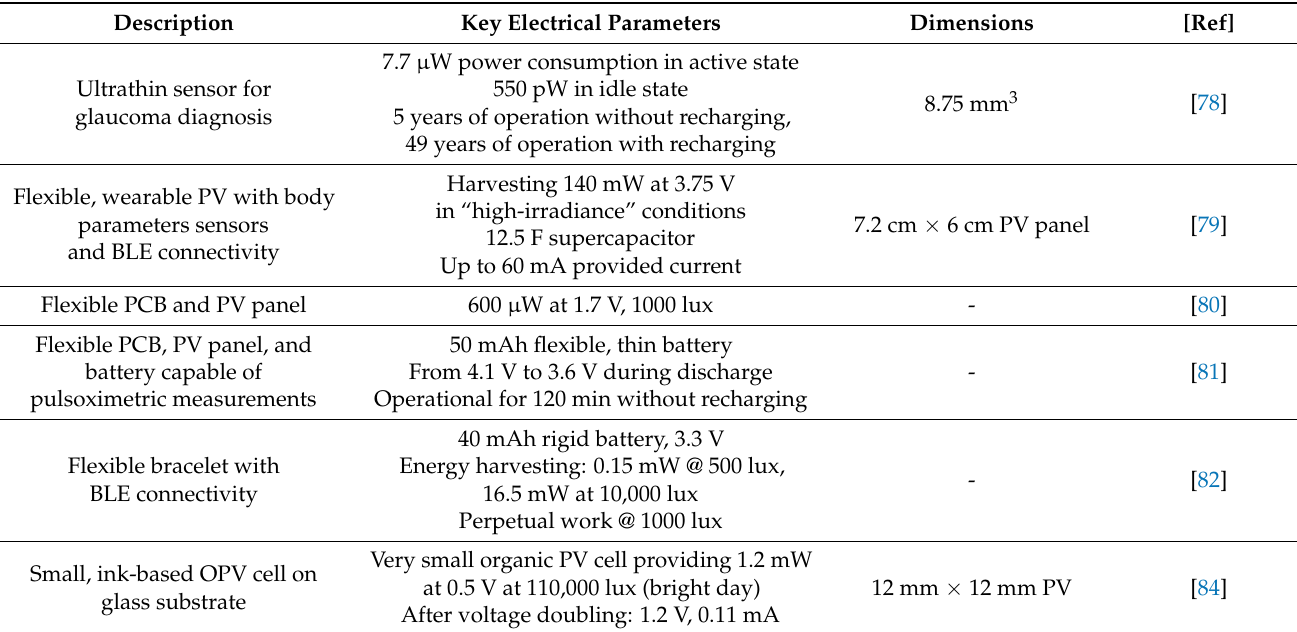
Table 9. Comparison of photovoltaic energy harvesting for wearables and Body Area